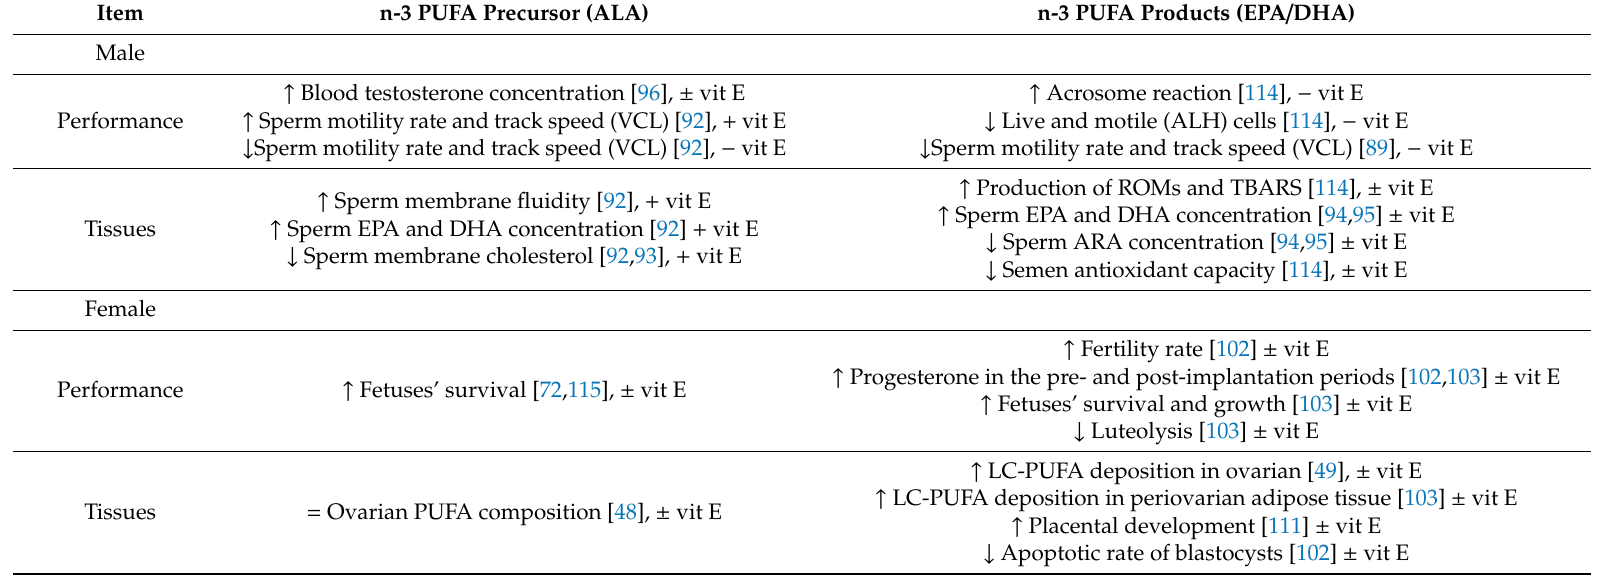
Table 1. E ff ect of n-3 PUFA dietary supplementation with ( + vit E) or without (– vit E) an appropriate antioxidant protection (200 mg / kg vitamin E), on rabbit reproductive